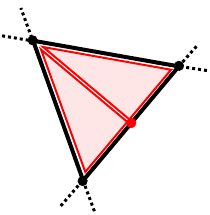
Figure 5 . Illustrative example for redundant rays and triangulations. We draw the intersection of a simplicial cone of a 3-dimensional fan with the unit sphere S 2 in black and that of two simplicial cones of another fan in red. The black lines correspond to the tropical hypersurfaces with rays of the associated fans at their intersections. The cone is further triangulated by two simplicial cones, drawn in red, due to the redundant ray that only lies on one of the